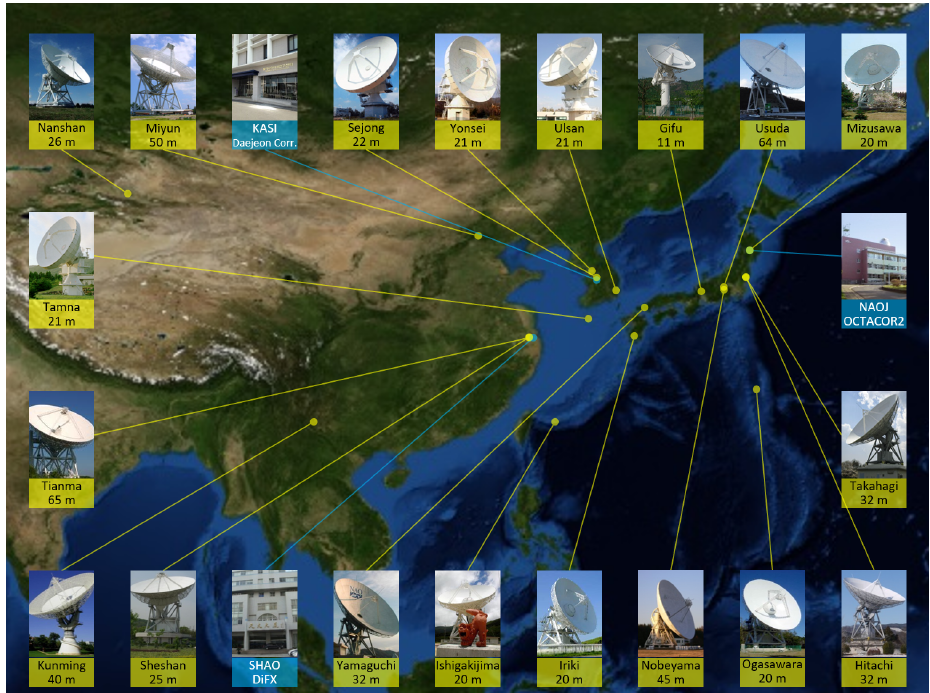
Figure 1. Concept map of EAVN including 16 active telescopes listed in Table 1, three potential telescopes (Miyun 50 m in China, Gifu 11 m, and Usuda 64 m in Japan), and three correlator sites in China, Japan, and Korea. Photographs of each radio telescope and correlator site are overlaid on ‘the Blue Marble’ image (credit of the ground image: NASA Earth Observatory (https://earthobservatory. nasa.gov/, accessed on 1 December